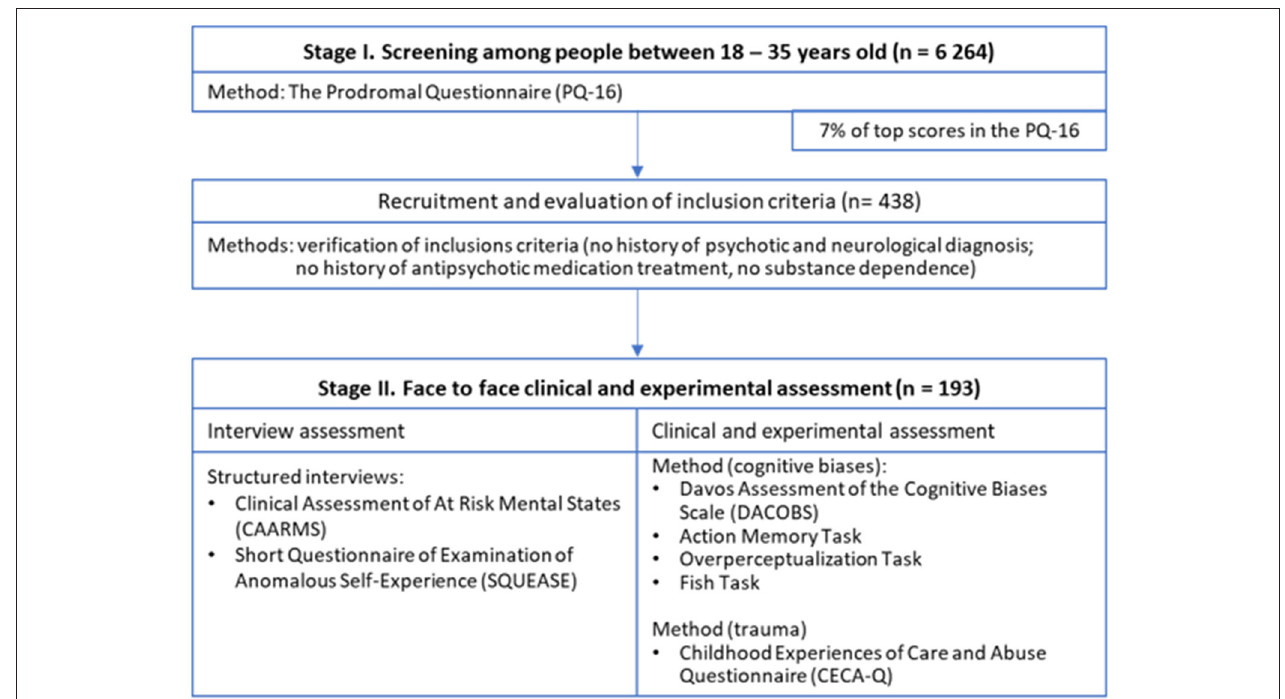
FIGURE 1 | Consort flow-chart presenting the course of the study.